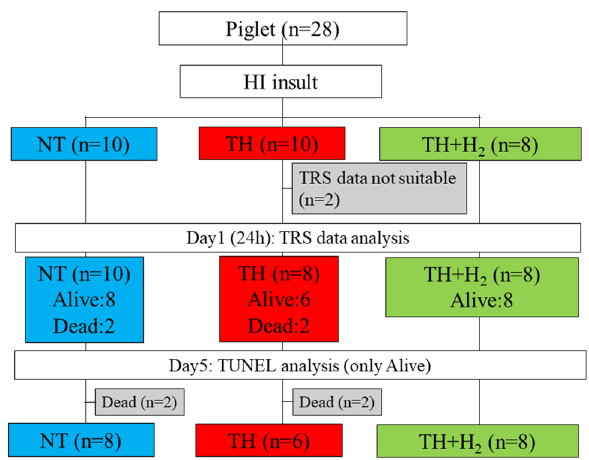
Figure 1. Study flow